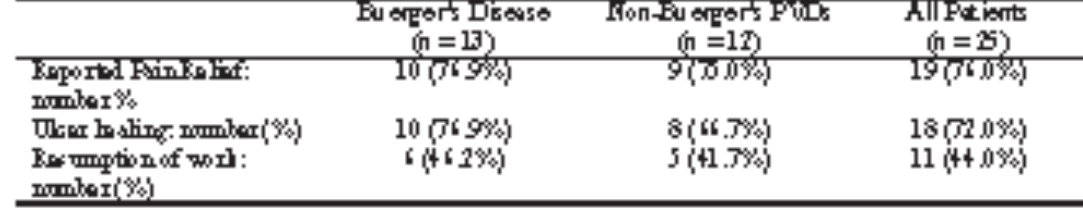
Table III : Pain Relief, Ulcer Healing and Resumption of Work at 3